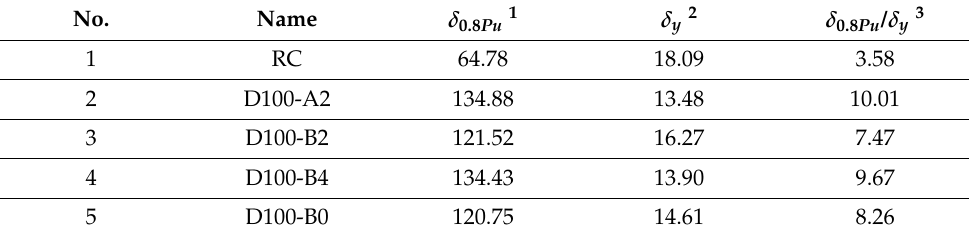
Table 7. Analysis of the ductility capacity for each specimen.